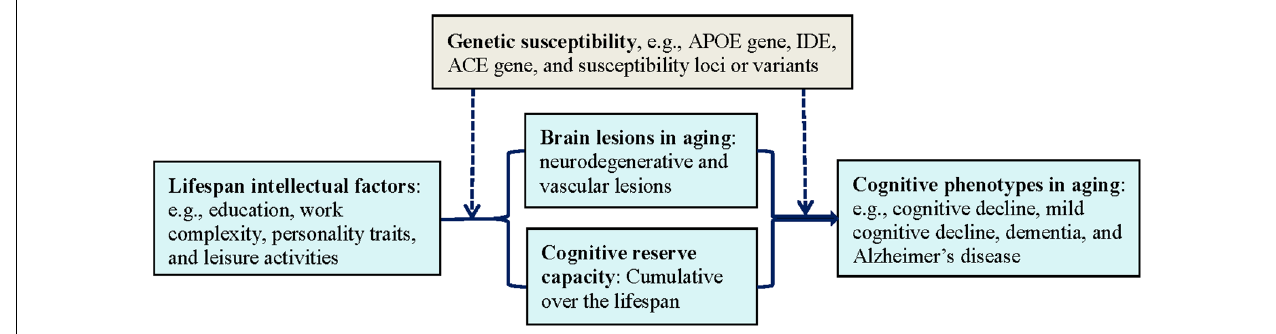
FIGURE 1 | The interplay of lifespan intellectual factors, cognitive reserve capacity, brain pathologies, and genetic susceptibility in cognitive phenotypes of aging. Abbreviations: ACE, angiotensin-converting enzyme gene; APOE, apolipoprotein E gene; IDE, insulin degrading enzyme